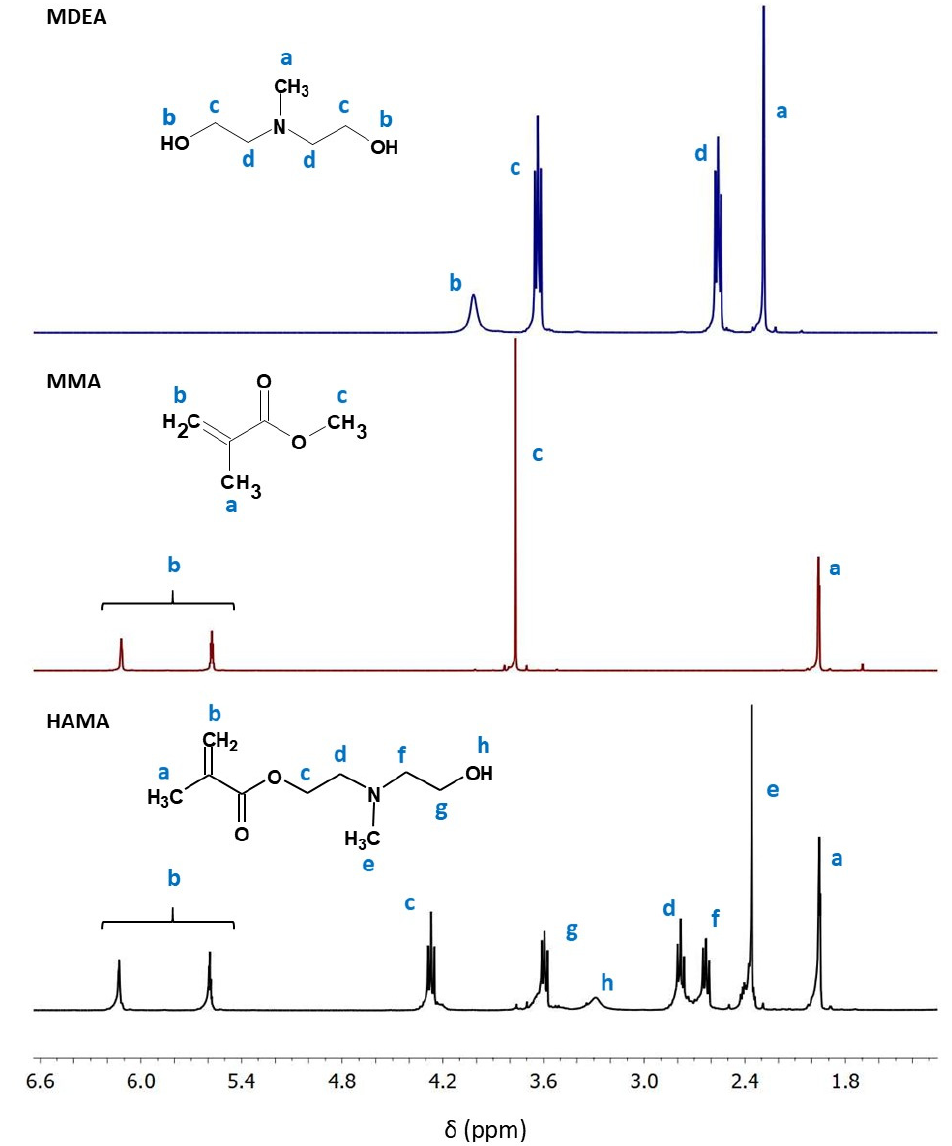
Figure 1. 1 H NMR spectra of MDEA, MMA, and HAMA. The 13 C NMR spectrum (Figure 2) shows the disappearance of the signal from the -COOCH 3 MMA carbon (51 ppm). The two signals corresponding to the MDEA carbon atoms -CH 2 OH and -CH 2 N< were further split into two more signals each (55, 58, 59, and 62 ppm).